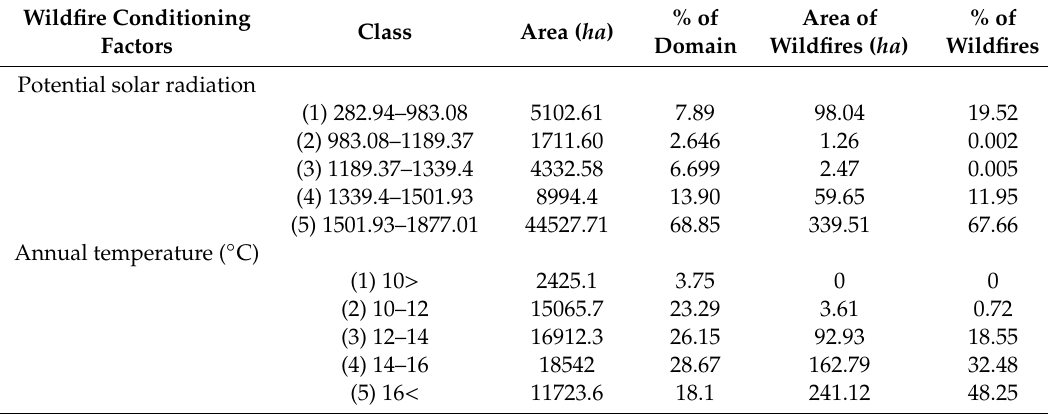
Table 3. The meteorological factors, the area of classes, and percent of the wildfire-a ff ected areas in each